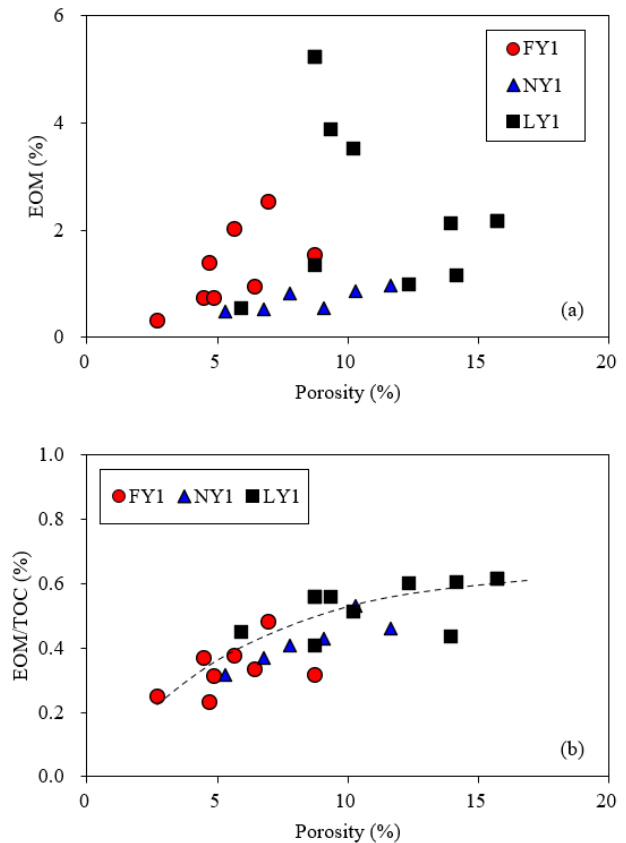
Figure 14. Relationships of porosity with EOM ( a ) and EOM/TOC ( b ) for the studied samples.